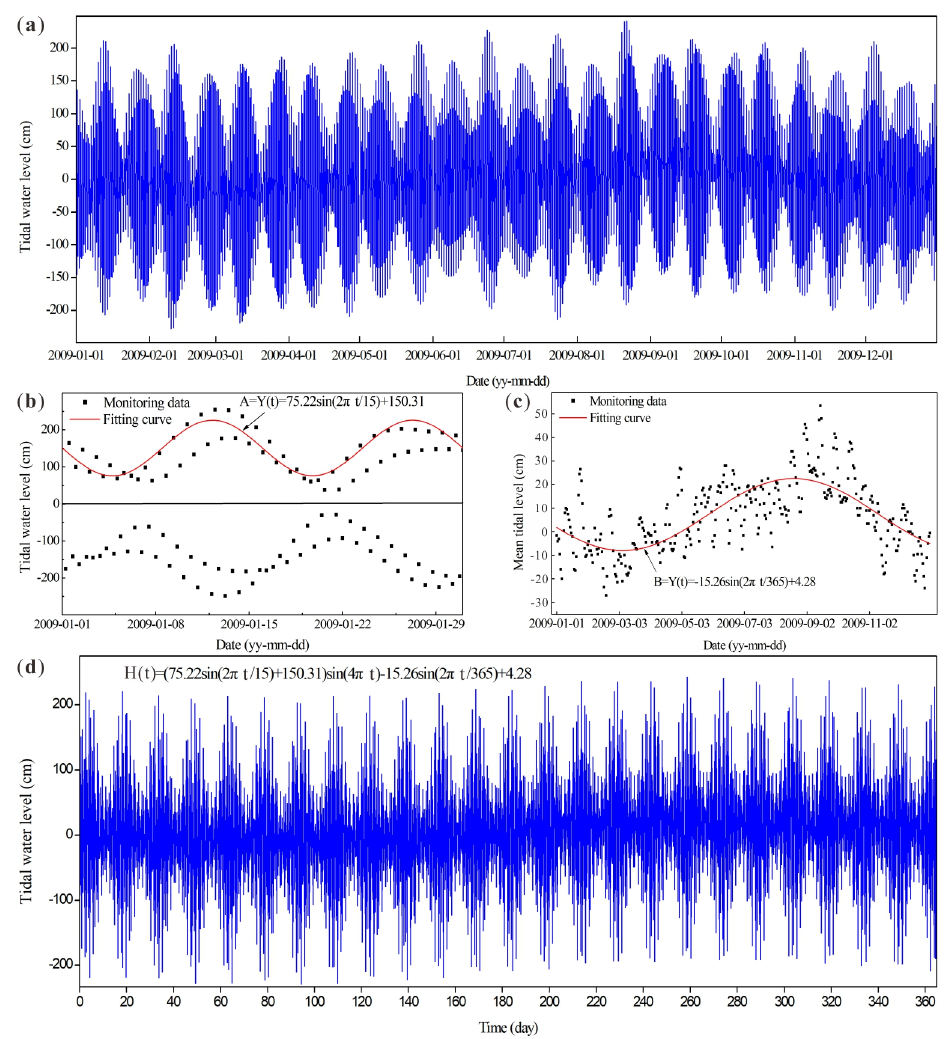
Figure 5. Tidal monitoring data and the fitting curve: ( a ) tidal monitoring data; ( b ) tidal amplitude and its fitting curve; ( c ) sinusoidal setover and its fitting curve; ( d ) fitting curve. Data source: The Navigation Guarantee Department of Chinese Navy Headquarters.